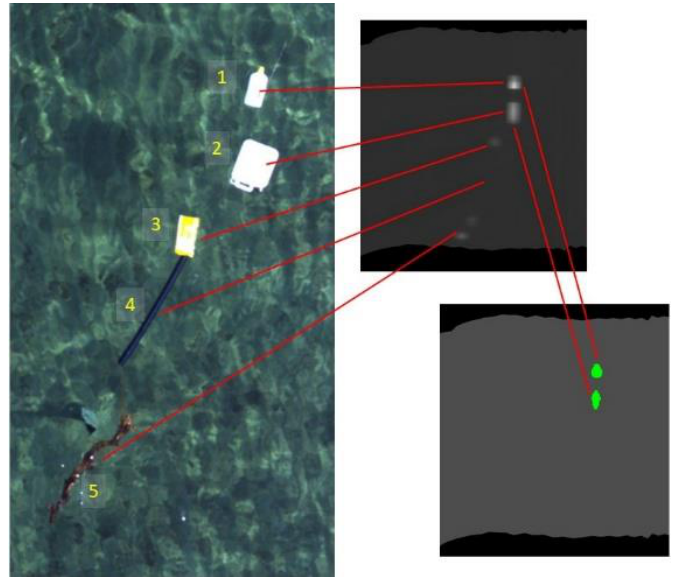
Figure 13. Detection of plastic objects in the sea of Platamona beach: (1) HDPE bottle; (2) unknown plastics canister; (3) metal-coated wrapper; (4) PVC pipe; (5) wood. Green denotes detected PE. As the PVC pipe is black, response in the SWIR spectrum is almost null, just as water, that appears completely dark throughout the sensor bandwidth.